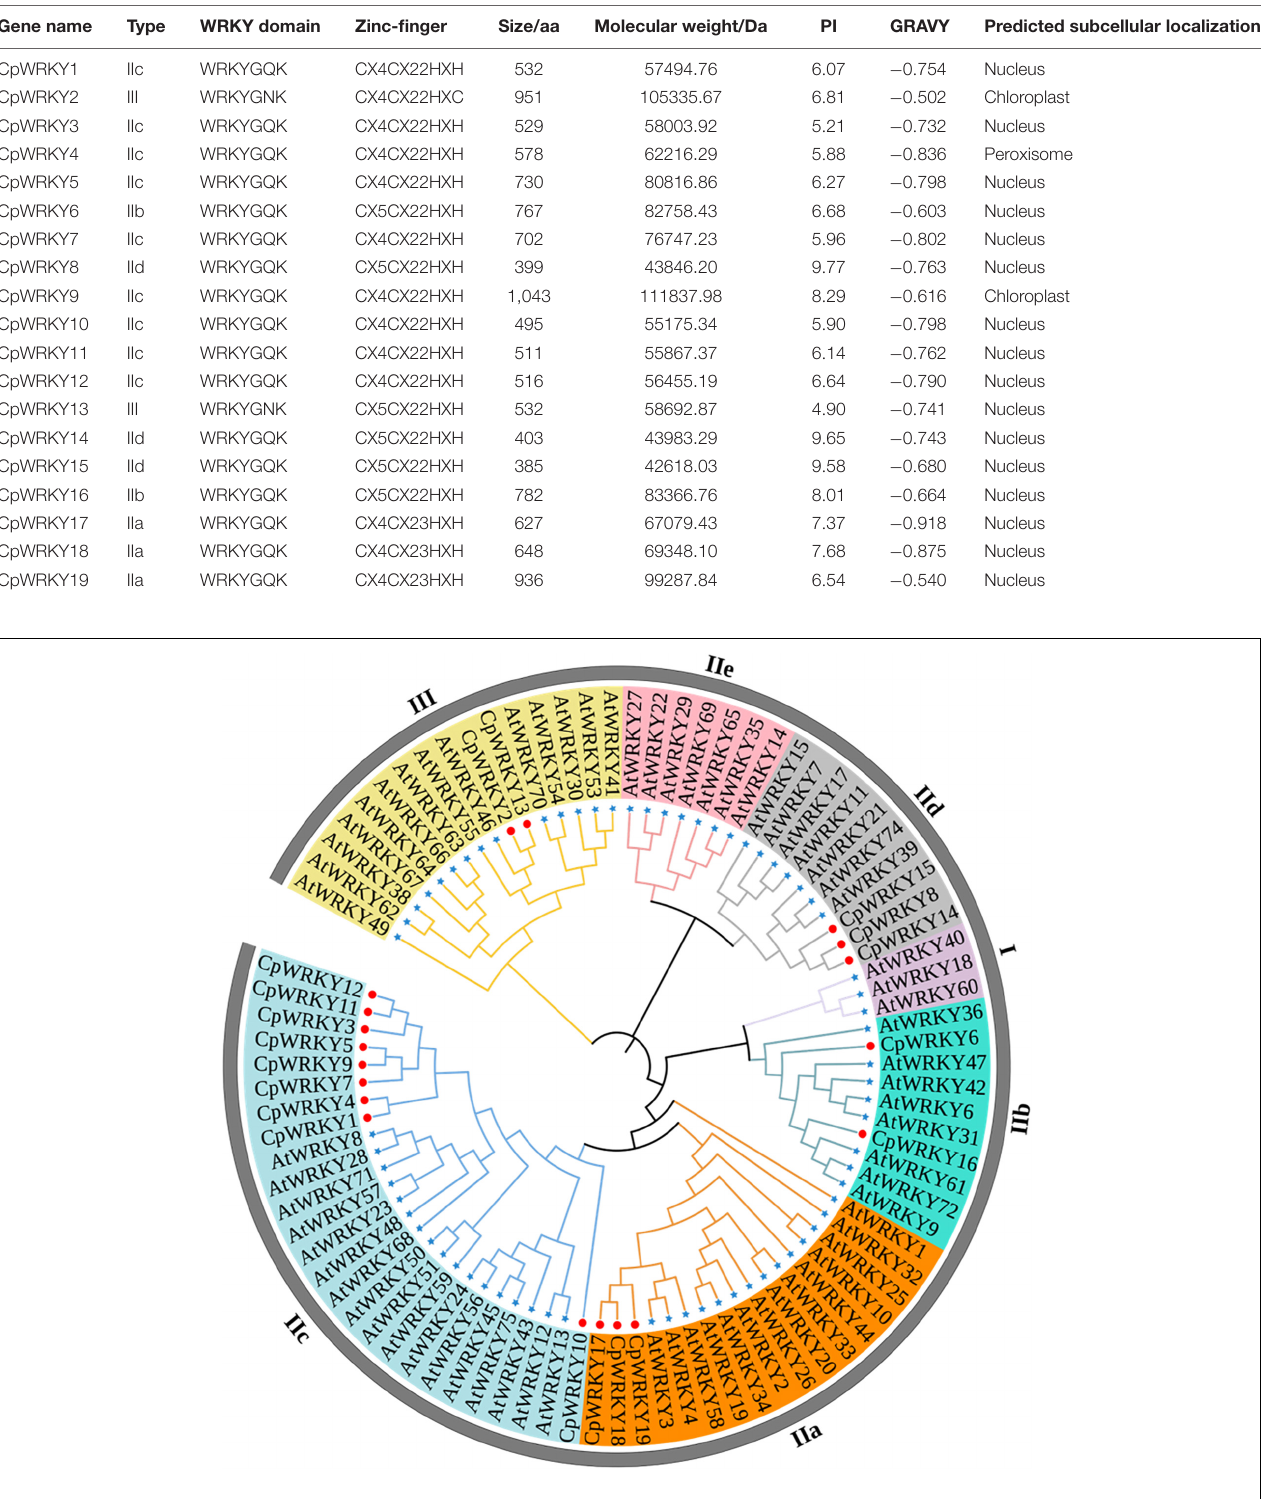
TABLE 1 | Basic information of WRKY gene family in Calohypnum plumiforme.